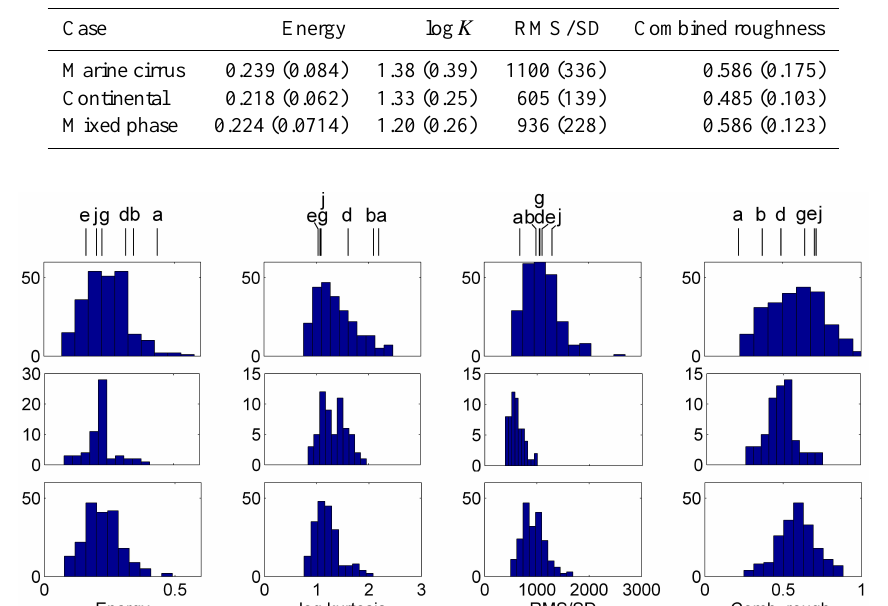
Table 1. Mean values and standard deviations (in brackets) of roughness measures of ice crystals in the three cloud cases shown in Fig. 6, obtained from 2-D SID-3 scattering patterns.